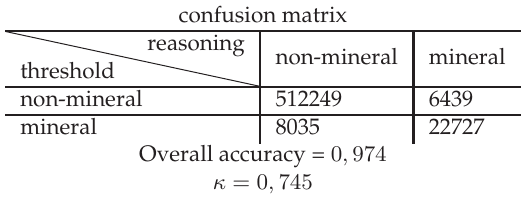
Table 2: Evaluation of ontological classification approach: confusion matrix comparing reasoning to threshold for mineral and built-up semantics.